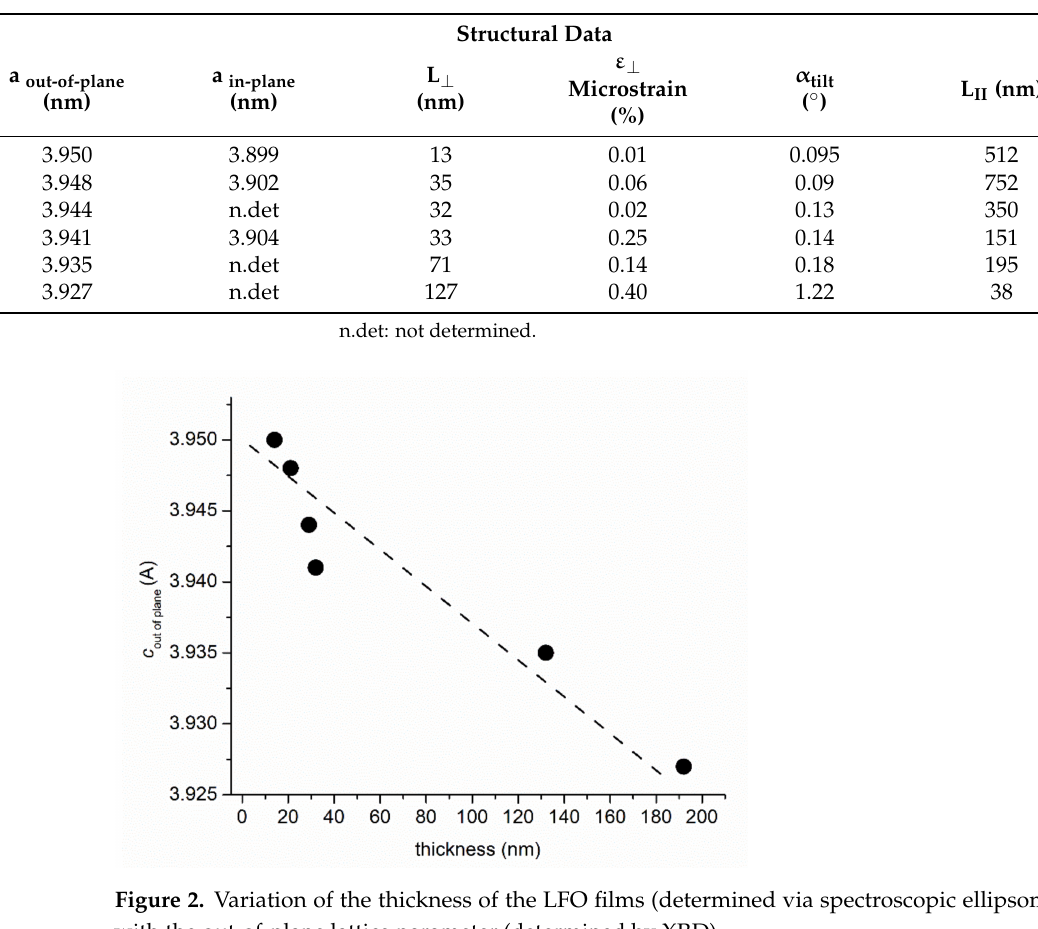
Table 1. The structural data of the LFO films. The thickness is determined by spectrometric ellipsometry. For three films, the thickness values were measured through high-resolution electron microscopy in cross-section (XTEM); the values are added in brackets.